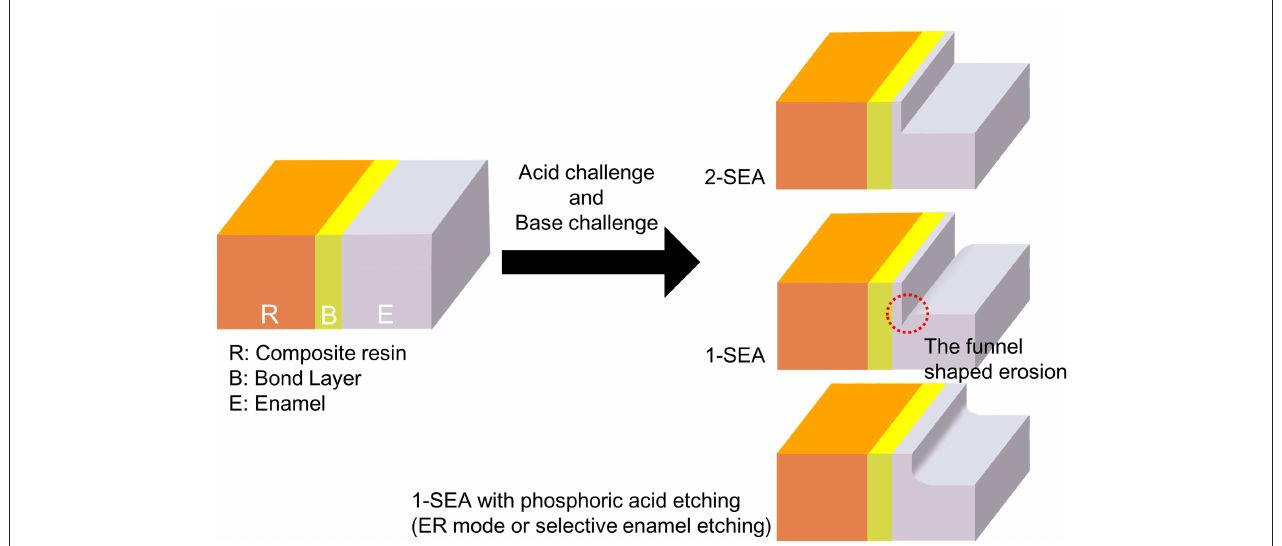
FIGURE 4 | Morphological differences in enamel ABRZ. The funnel-shaped erosion was detected beneath the bonding interface with 1-SEAs. The formation of this erosion can be prevented by prior PA